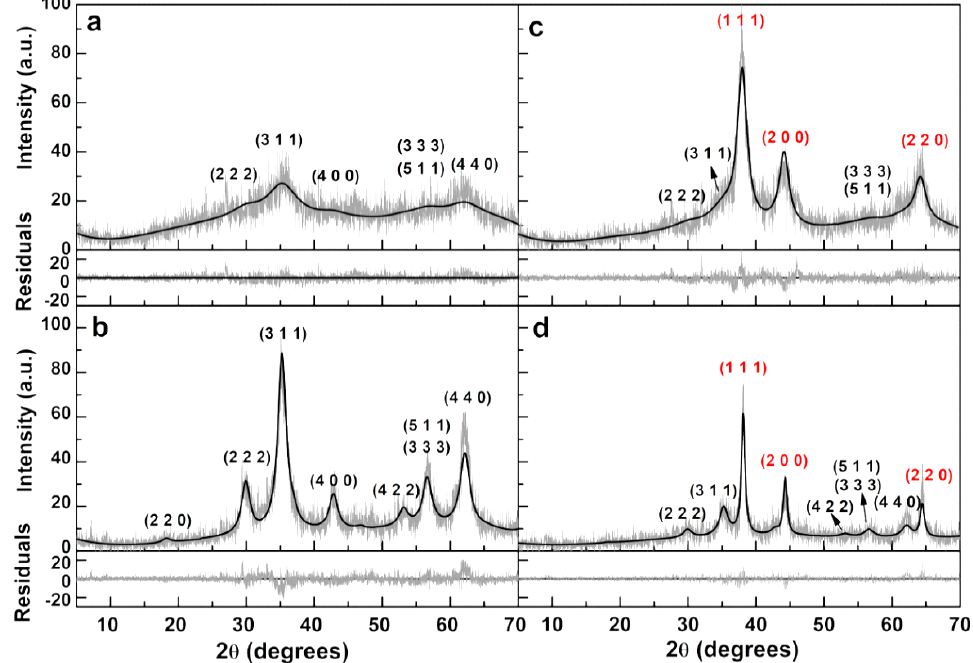
Figure 2. XRD diffractograms of zinc/calcium ferrite nanoparticles: ( a ) Non-calcined zinc/calcium ferrite; ( b ) calcined zinc/calcium ferrite; ( c ) non-calcined zinc/calcium ferrite decorated with silver; ( d ) calcined zinc/calcium ferrite decorated with silver. Gray lines: Experimental patterns; black lines: fitted patterns. Miller indices: Black: zinc/calcium ferrite; Red: Silver. Table 2. Selected Rietveld analysis parameters.